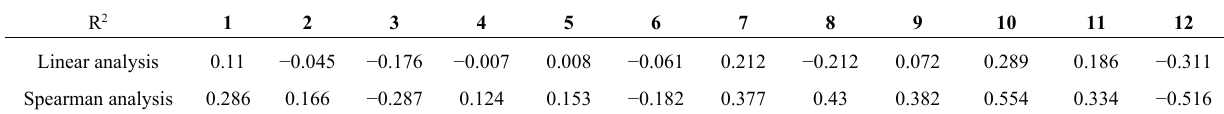
Figure 6. The relationship between PM 2.5 and wind speed in a year. Table 3. Correlation between PM 2.5 and wind speed in a year.